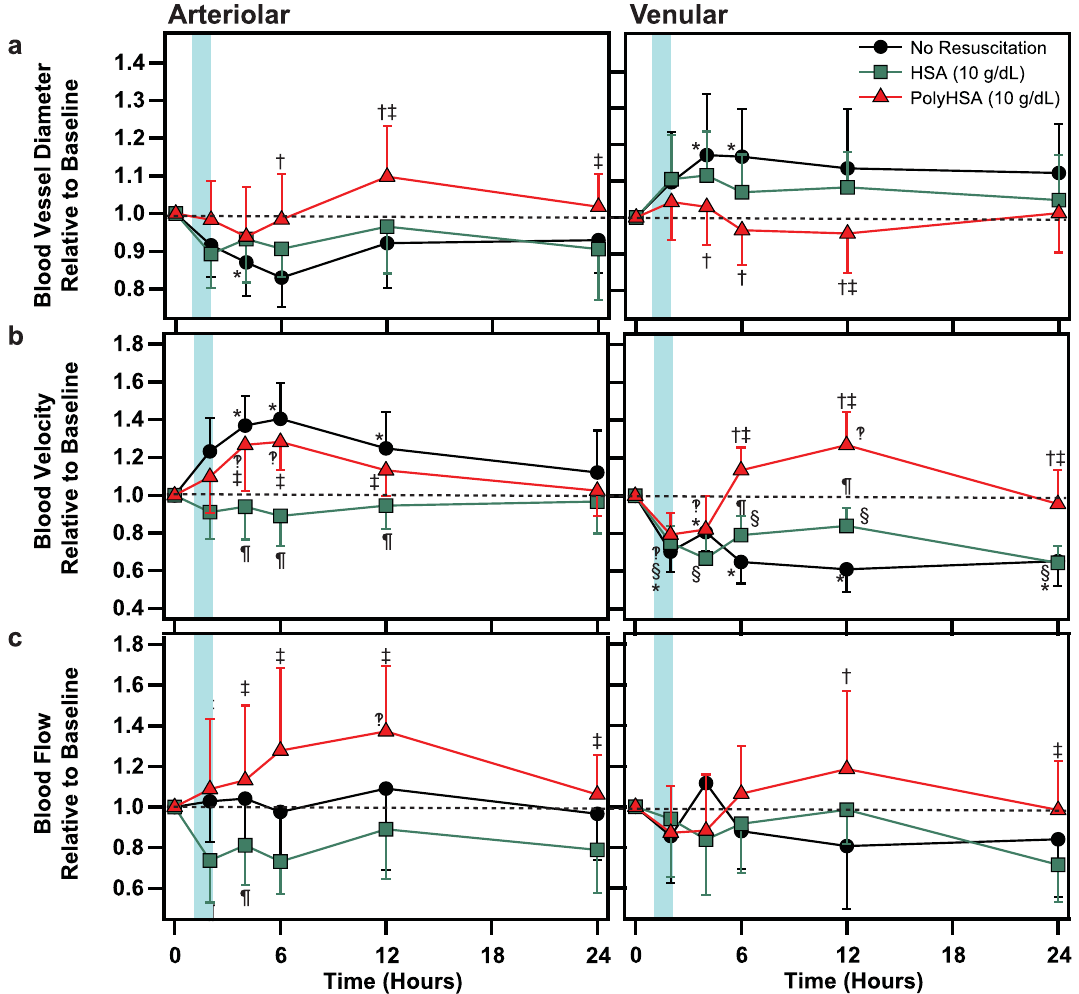
Figure 8. Changes in microhemodynamics following CLP induced polymicrobial sepsis. Arteriolar and venular ( a ) blood vessel diameter, ( b ) blood fluid velocity, and ( c ) blood flow with no resuscitation, infusion of HSA, or infusion of PolyHSA. † P < 0.05 between the PolyHSA and no resuscitation groups at the same time point. ‡ P < 0.05 between the PolyHSA and HSA groups at the same time point. ¶ P < 0.05 between the HSA and no resuscitation groups at the same time point. Symbols next to data points indicate a significant (P < 0.05) difference at that time point compared to baseline conditions for (*) no resuscitation, (§) HSA, and ( ‽ ) PolyHSA (n = 6